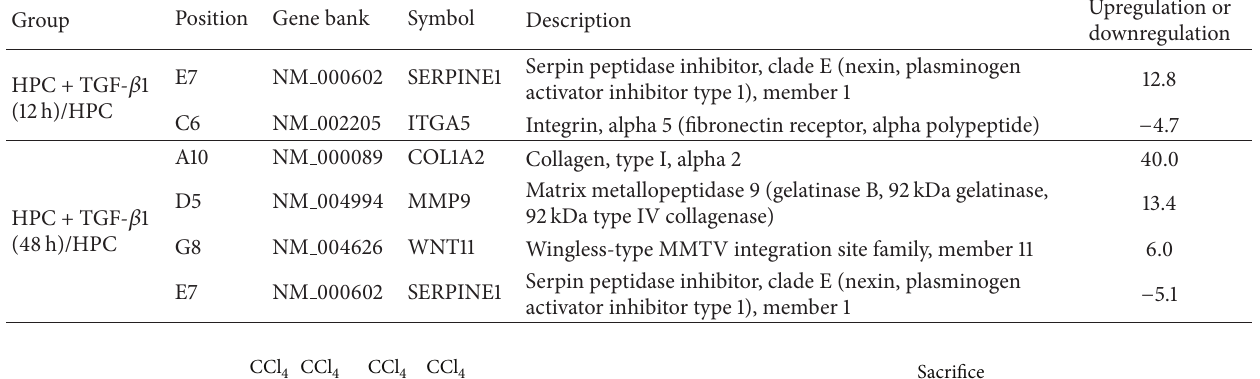
Table 2: Variation in the ECM related gene expression between HPCs control and TGF- 𝛽 1-treated HPCs in RT 2 profiler PCR array. Group Position Gene bank Symbol Description